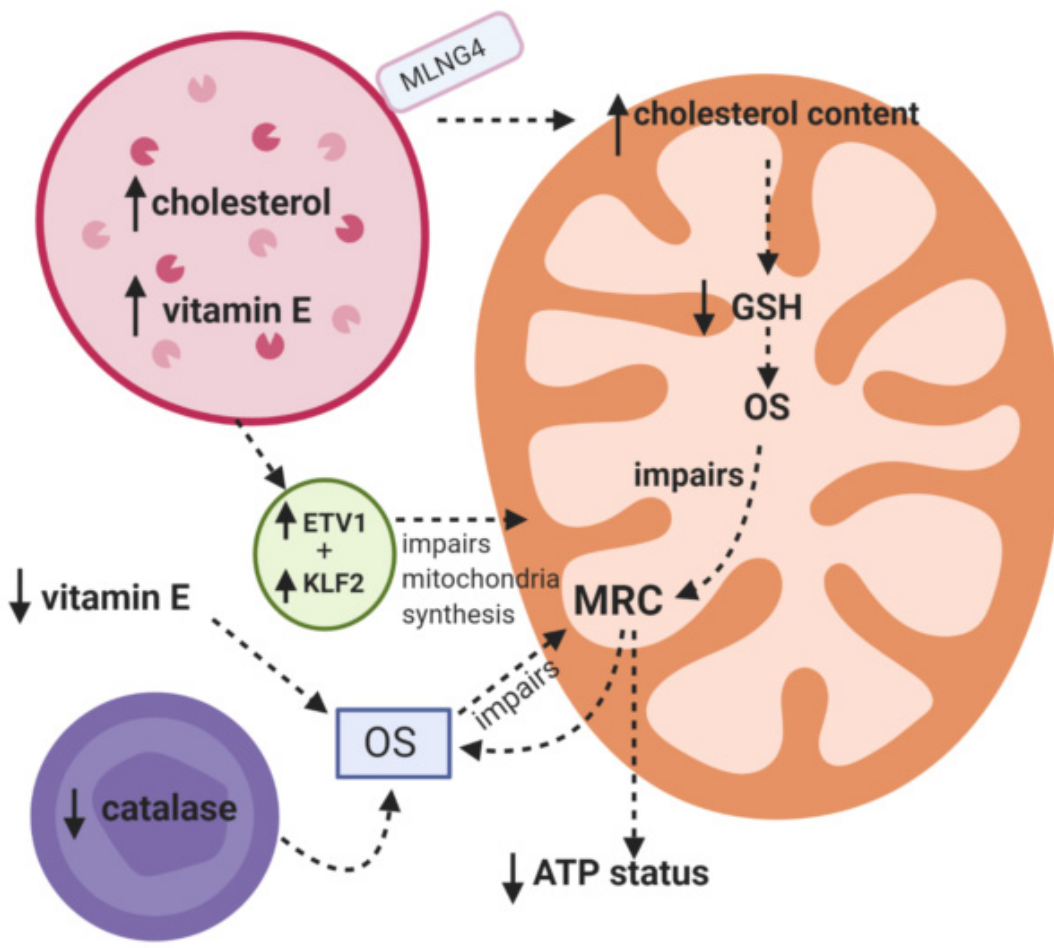
Figure 1. Putative mechanisms responsible for mitochondrial dysfunction in Niemann Pick C. MRC: Mitochondrial respiratory chain. ETV1: Transcription factor. KLF2: Transcription factor. OS: Oxidative stress. GSH: Reduced glutathione.